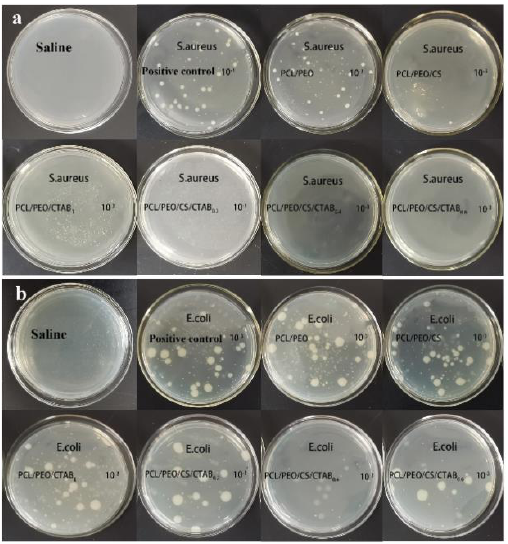
Figure 8. Images of the quantitative inhibition circles of composite films: ( a ) E. coli ; ( b ) S. aureus .